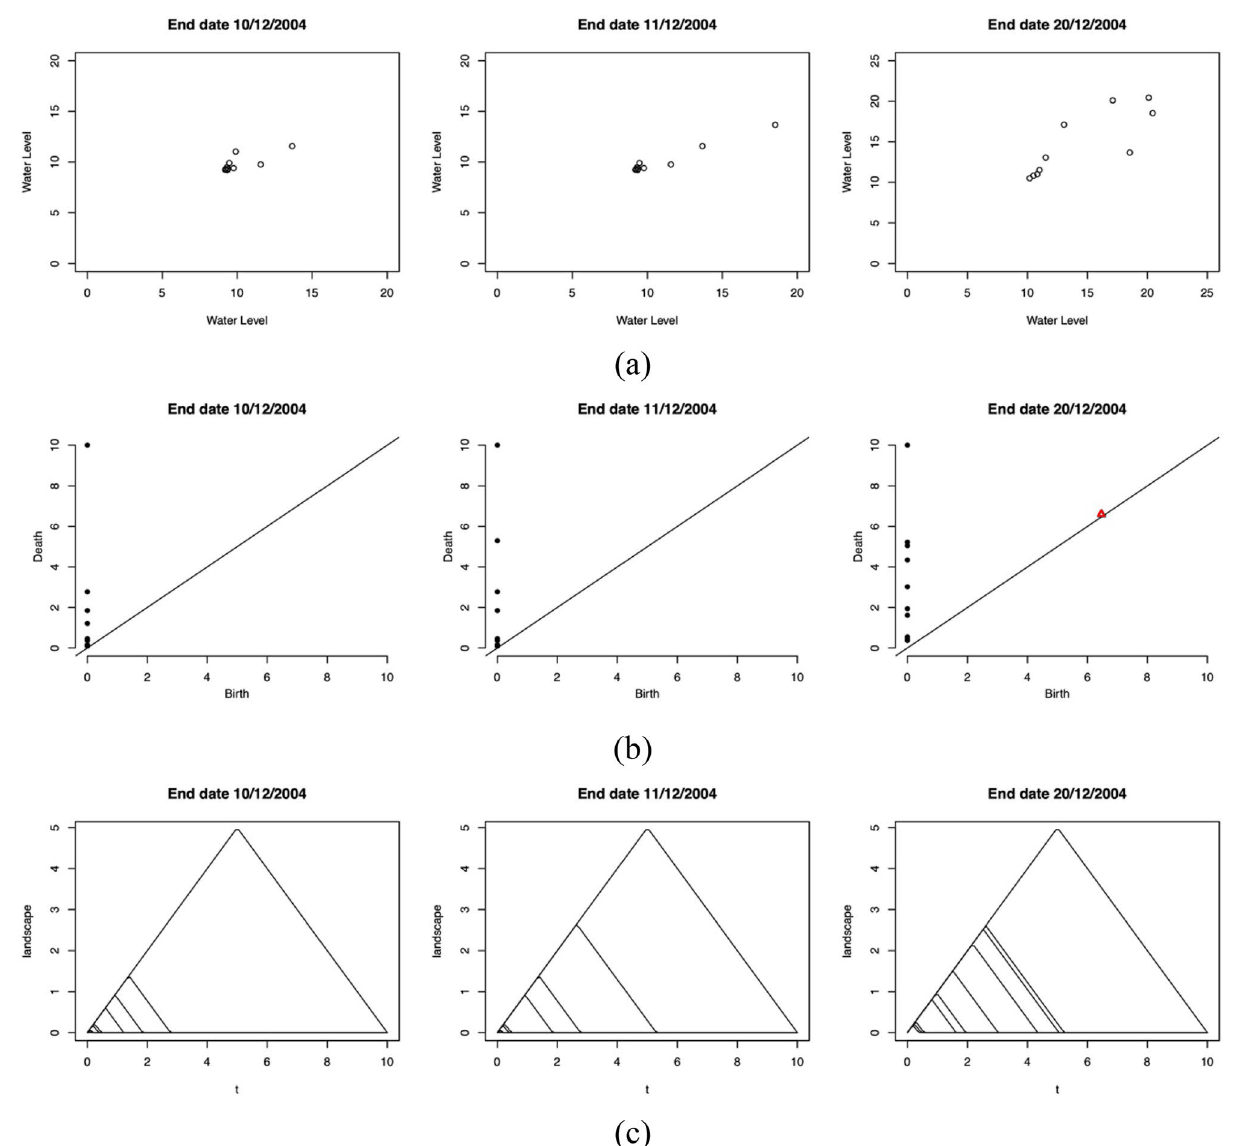
Figure 5. ( a ) Reconstructed phase space, ( b ) persistence diagrams, and ( c ) zero-dimensional persistence landscapes for windows with selected end dates during the flood events of